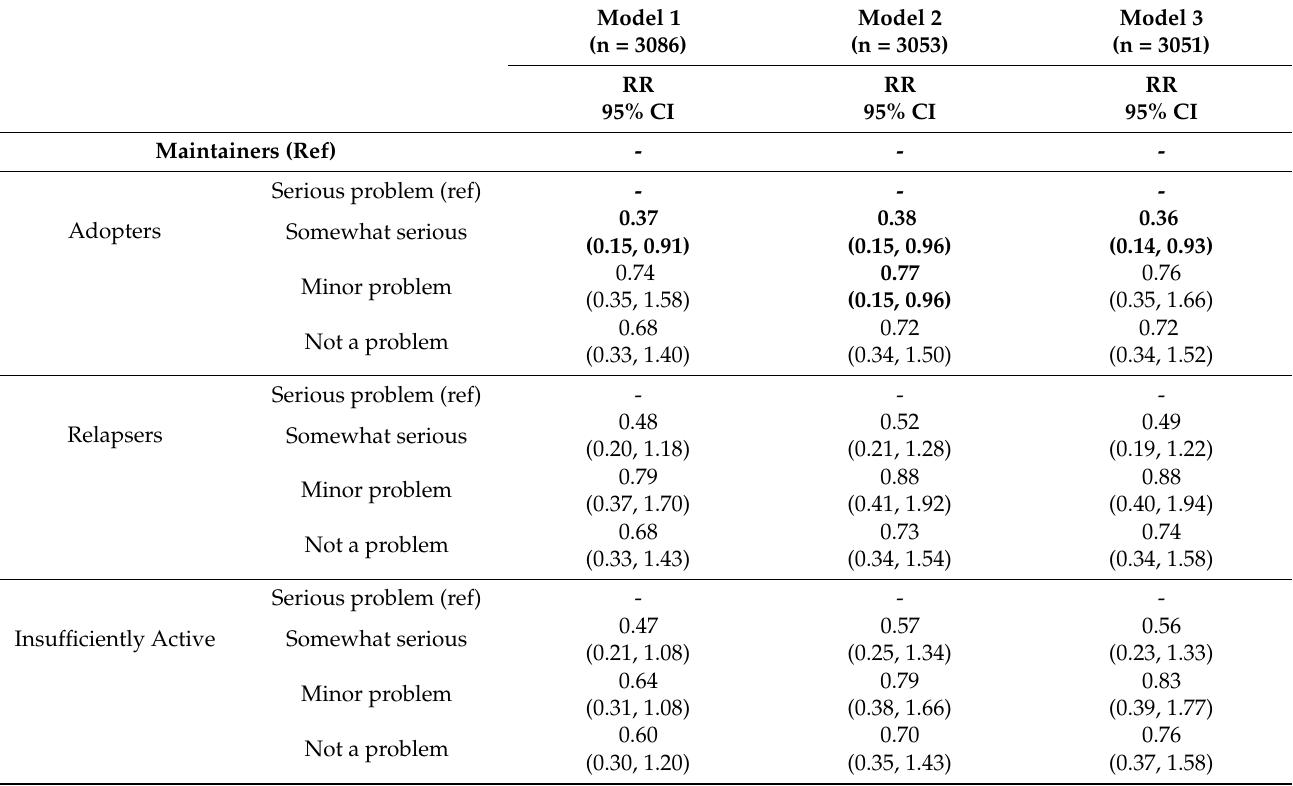
Table 4. Multinomial regression models assessing the association between the perception of poor sidewalks in the neighborhood and patterns of